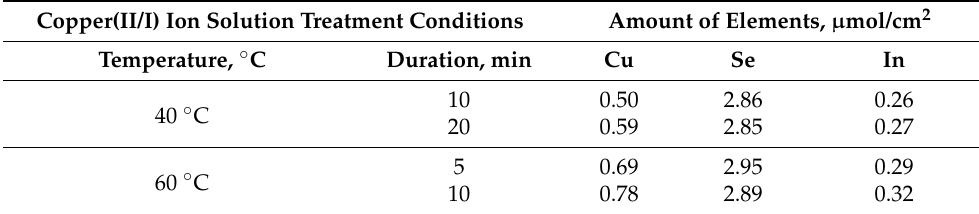
Table 1. Amount of Cu, Se, and In in In- incorporated Cu x Se films on glass.